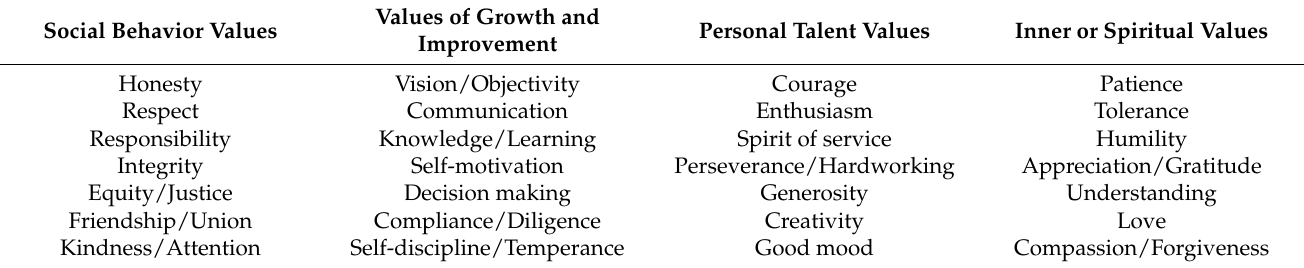
Table 1. Ethical values and Indicators applied empirically in the instrument to evaluate the perception of the behavior of ethical values of the university graduates of the sample when performing in the role of leadership, teamwork, effective communication and